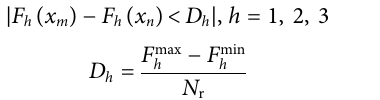
FIGURE 2 | Regroup operation of salp population for global